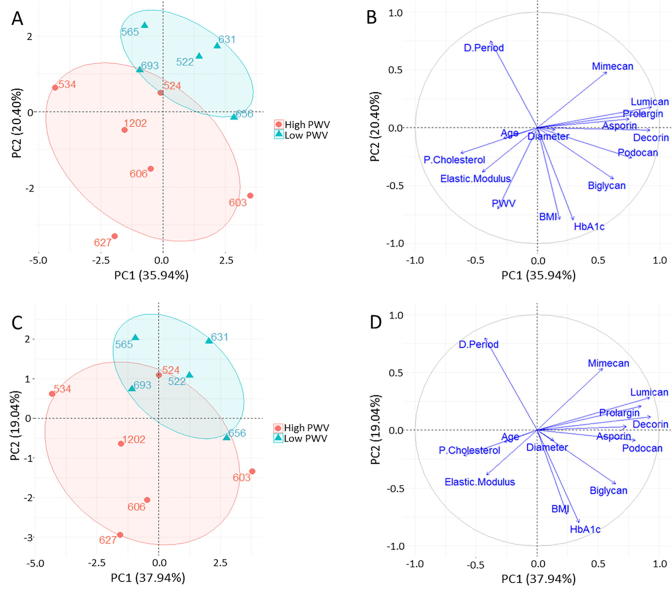
Principal component analysis (PCA) of patient proteomics, quantitative metadata and nanomechanical variables. (A) Score plot of the two first principal components. Each dot represents a patient. Patients coloured by group, ellipses represent the 67% region around the mean of the points of each group. (B) Loading plot of (A) showing the variables that contribute the most to the structured observed in (A); PWV and Elastic modulus are two of the most contributing variables to the separation between both groups. (C) Score plot of the two principal components of patient data without the PWV variable. Similar separation between both groups can be observed. (D) Loading plot of (C) shows how elastic modulus is one of the most contributing variables to the separation observed. Of the SLRPs, mimecan presents the most contribution to the separation between groups observed.